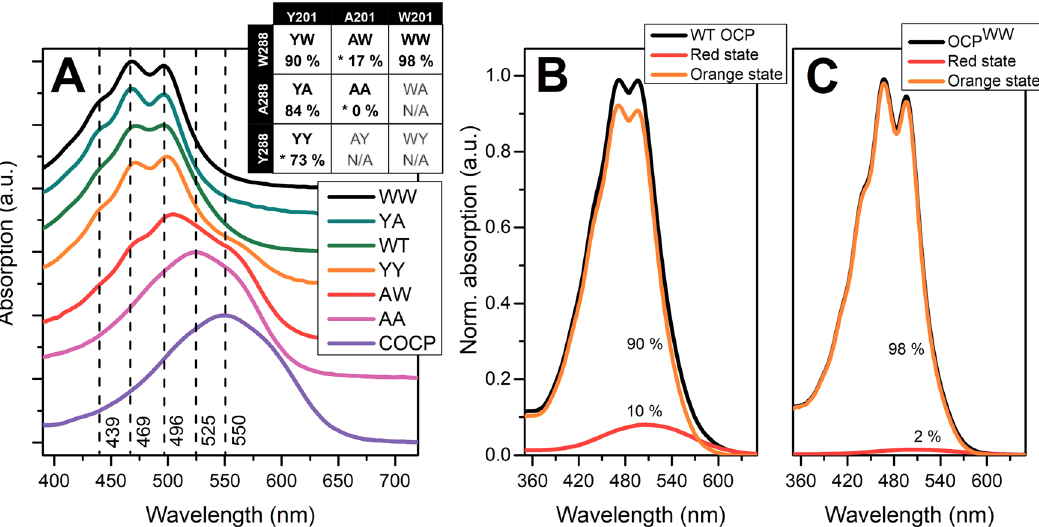
Fig. 1 Variability of carotenoid absorption in OCP and its variants. A Absorption spectra of OCP and sequence variants thereof in 0.8 M phosphate. The inset shows the fractional content of the orange photoactive form. Asterisks represent OCP species not forming the orange state upon expression and puri fi cation from ECN/CAN producing E. coli strains; the orange compact forms of CAN-containing OCP YY and OCP AW appeared only in 0.8 M phosphate. “ COCP ” corresponds to the individual OCP-CTD forming a dimer coordinating CAN. B , C decomposition of the absorption spectra of the compact forms of WT OCP ( B ) and the OCP WW variant ( C ) corresponding to the central positions of the elution peaks (apparent Mw ~35 kDa) on analytical SEC with full- spectrum detection. To estimate the yield of distinct spectral states, the absorption spectrum of the photoactivated protein was subtracted from the dark- adapted sample with an appropriate scaling factor. Numbers indicate the percentage of the orange and red states. Table 1 OCP WW X-ray data collection and re fi nement